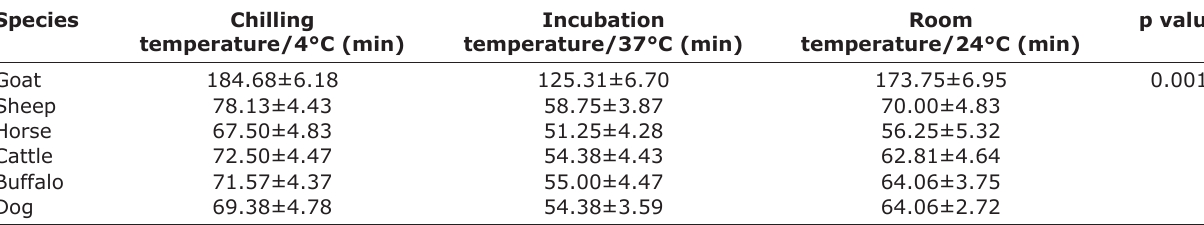
Table-3: Time required for HA of mammalian RBC with NDV (lasota strain) within different temperatures (mean±SD). Species Goat Sheep